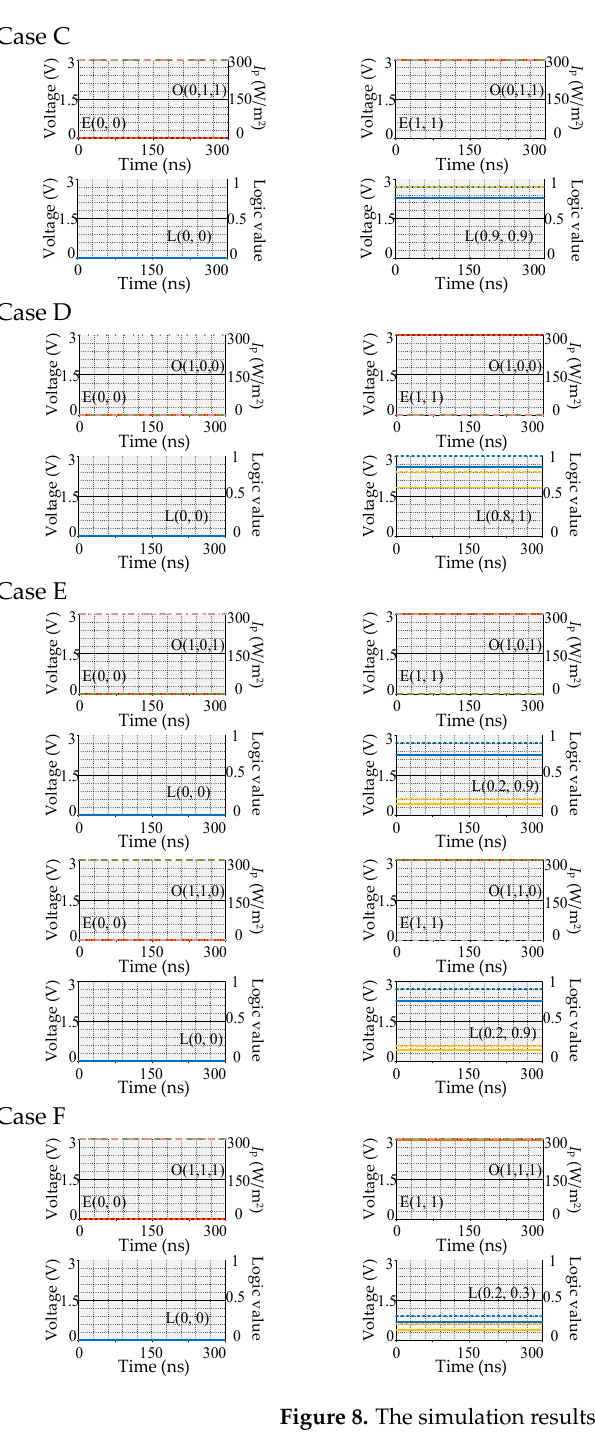
E) contains two cases, B 2 = I pl , B 3 = I ph and B 2 = I ph , B 3 = I pl , for which the simulation results